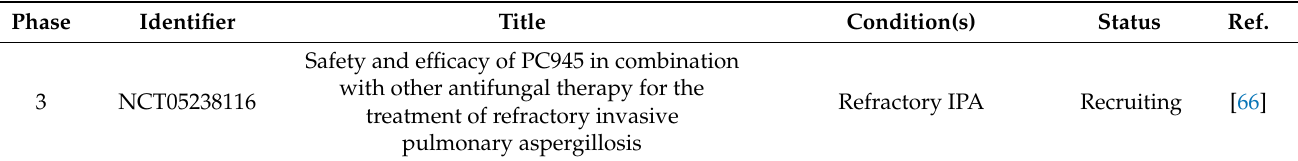
Table 5. Clinical trials of PC945 ( 16 )